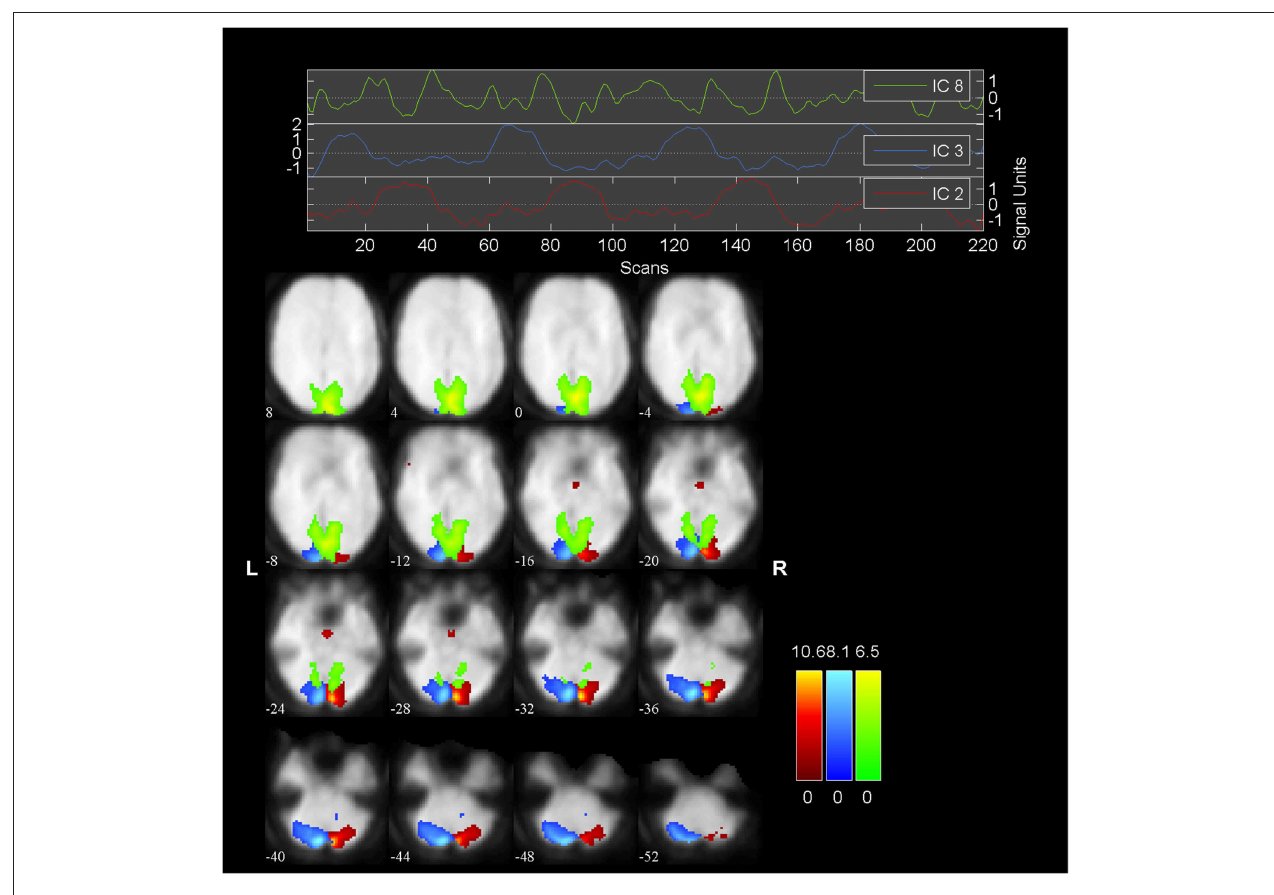
FIGURE 7 | Result of the real fMRI